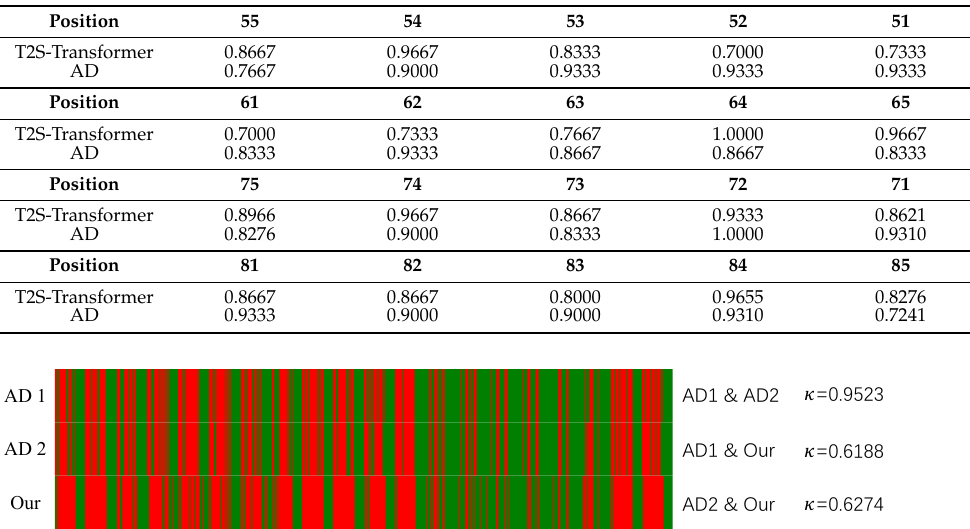
Figure 6. Observations by the dentists and predicted results of our method. Red and green lines represent caries and normal teeth, respectively. The kappa values are